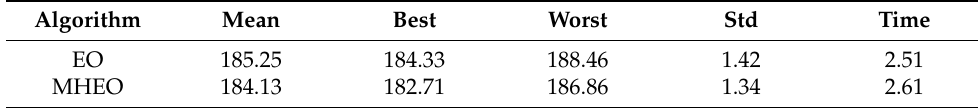
Table 2. Comparison of path planning results